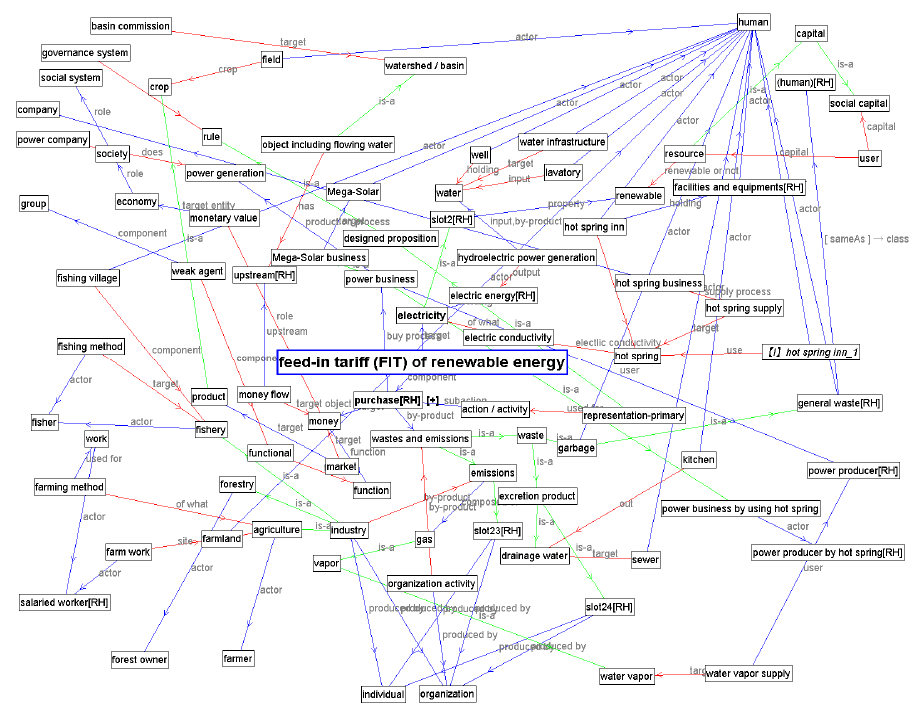
Figure 12. The “feed ‐ in tariff (FIT) of renewable energy”–agent nexus system map.